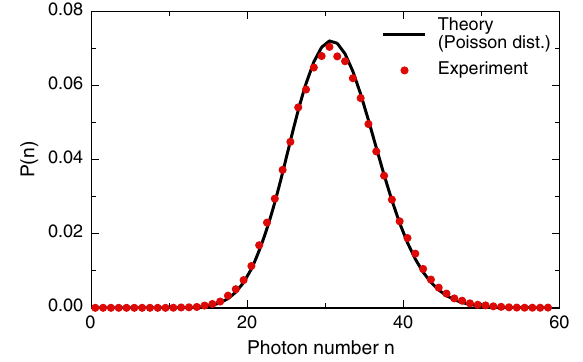
FIG. 5. Statistics of the number of photons detected by a single-photon detector (ID Quantique ID100) in 1ms, which, as expected for most sources, follows a Poisson distribution.